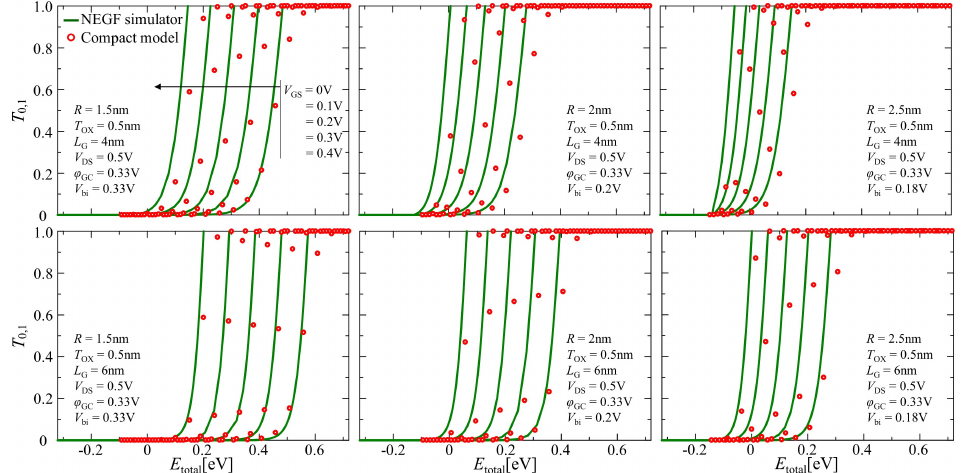
Figure 8. Comparison of the transmission coefficient calculations results between the NEGF simula- tion (solid line) and our numerical compact model (open circle) for the lowest